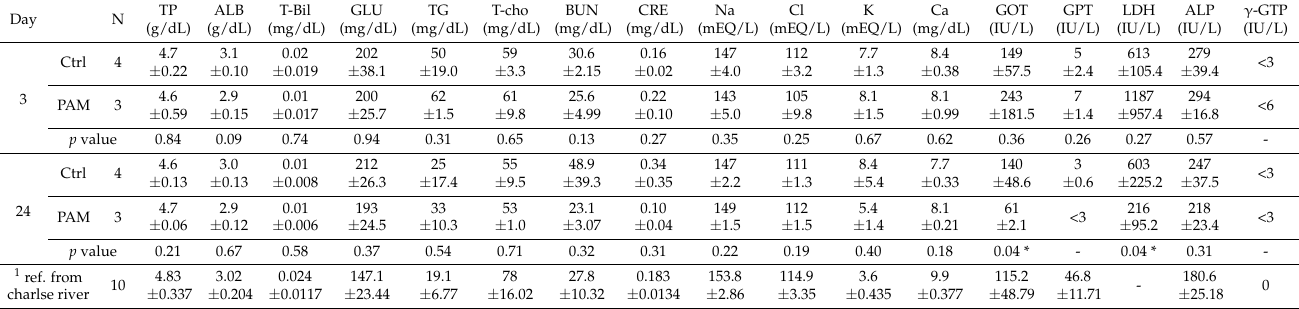
The outline of the PAM treatment was the same as that in Figure 3a without ES2 injection. 1 Reference from https://www.crj.co.jp/cms/crj/ pdf/product/rm/information/balbcnu/Control_data_BALBc-nu_2010.pdf (24 November 2020). Data are the mean ± SD. The Student’s t -test was carried out between control (Ctrl) and PAM treated group (PAM). Statistics are shown as * p < 0.05. The abbreviations are as follows: TP; total protein, ALB; albumin, T-Bil; direct bilirubin, GLU; glucose, TG; triglyceride, T-cho; total cholesterol, BUN; blood urea nitrogen, CRE; creatinine, Na; sodium, Cl; chlorine, K; potassium, Ca; calcium, GOT; glutamate oxaloacetate transaminase, GPT; glutamate oxaloacetate transaminase, LDH; lactase dehydrogenase, ALP; alkaline phosphatase, γ -GTP; gamma-glutamyl